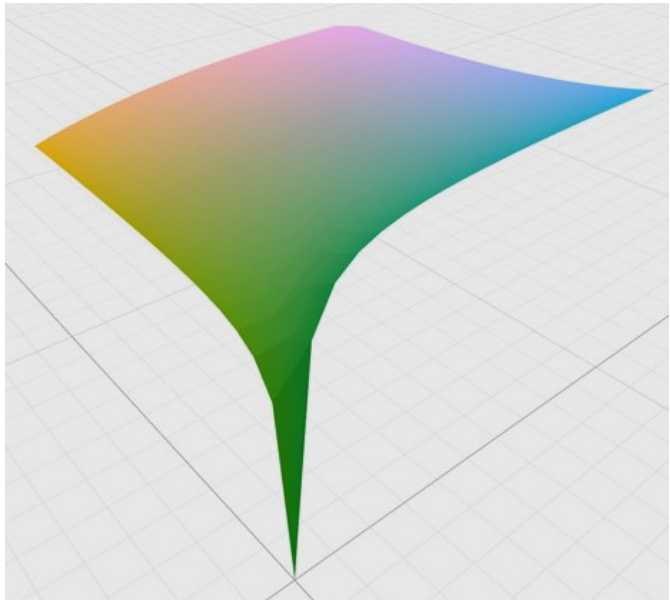
Figure 20. Anger + Fear—neuroticism factor.